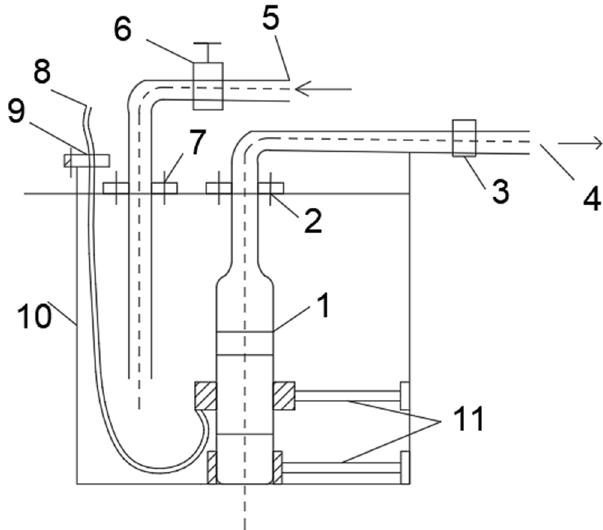
Figure 27. Test system diagram: 1—test pump (including motor); 2—test pump support mechanism; 3—flow meter; 4—outlet pipe; 5—return pipe; 6-regulating valve; 7—return pipe support member;